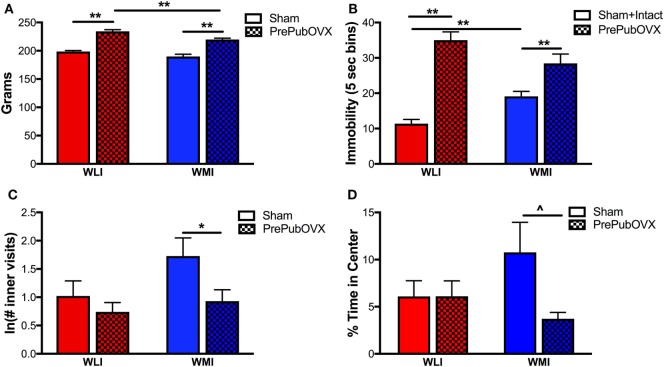
Removal of ovarian hormones before puberty alters body weight, depression- and anxiety-like behaviors. (A) Body weights as measured in grams in Sham and prepubertally ovariectomized adult female Wistar Kyoto (WKY) less immobile (WLIs) and WKY more immobiles (WMIs). (B) Immobility behavior in the forced swim test measured every 5 s (5 s bins). Immobility of intact animals did not differ from those of shams’ and therefore, data were combined. (C) Natural logarithm of the number of visits to the inner area of the open field arena and (D) percent time spent in the inner area of the open field arena. Lines marked by **p < 0.01 and *p < 0.05 reflect Bonferroni-corrected post hoc analyses. ^p < 0.05 by Student’s t-test, as hypothesis testing between two groups, when ANOVA is significant or a trend (p < 0.1). Data are presented as mean ± SEM.